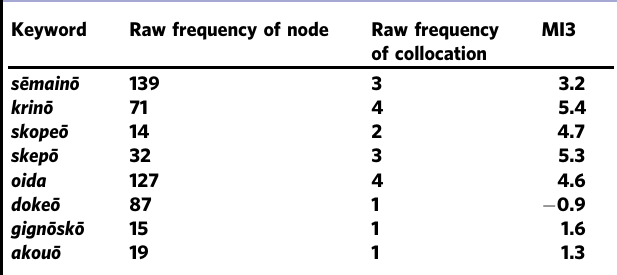
Table 12 Collocation of keyword with S Ē MEION, raw frequency = 104. Keyword